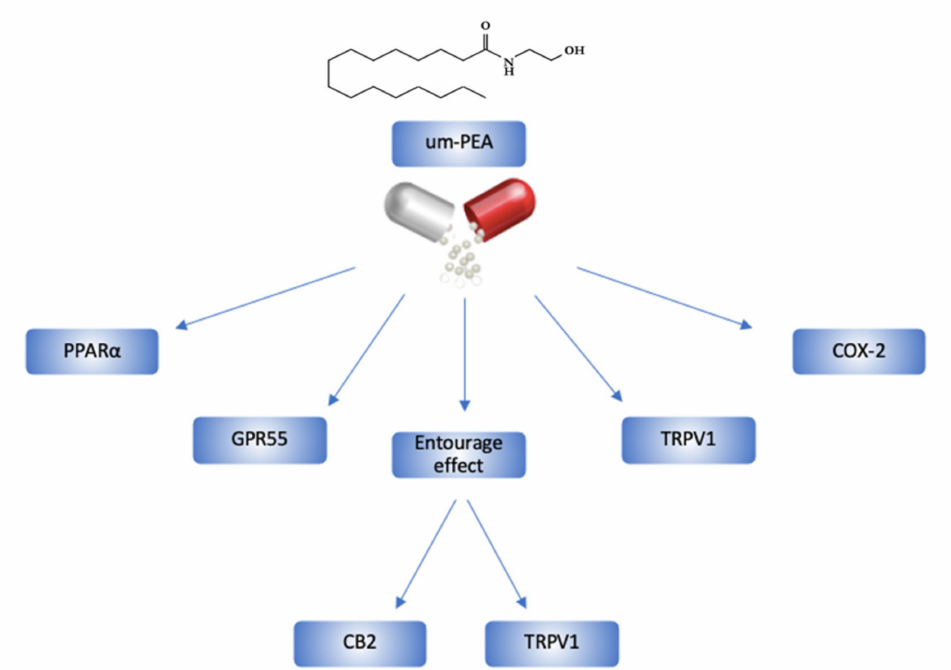
Figure 2. um-PEA’s chemical structure and its mechanism of action in the human body. CB2, cannabi- noid 2; COX-2, cyclooxygenase-2; GPR55, G-protein-coupled receptors 55; PPAR α , peroxisome proliferator-activated receptor α ; TRPV1, transient receptor potential vanilloid